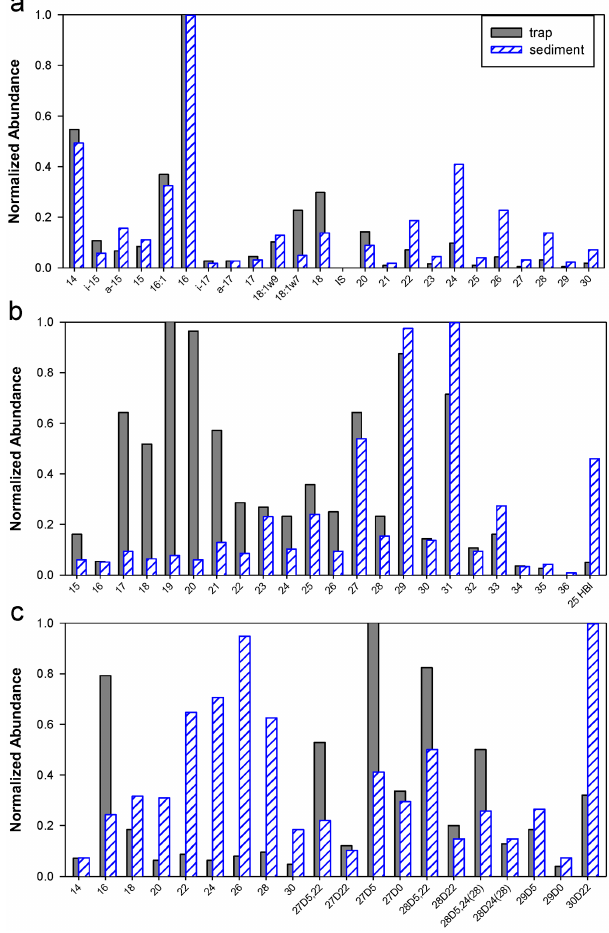
Figure 5. Histograms of relative abundances of (a) fatty acids, (b) hydrocarbons and (c) sterols/alcohols in POM and SOM from the Black Sea. Carbon numbers are given for fatty acids, alkanes and alcohols; sterol abbreviations are 27D5,22 = 27 (cid:49) 5 , 22 ,